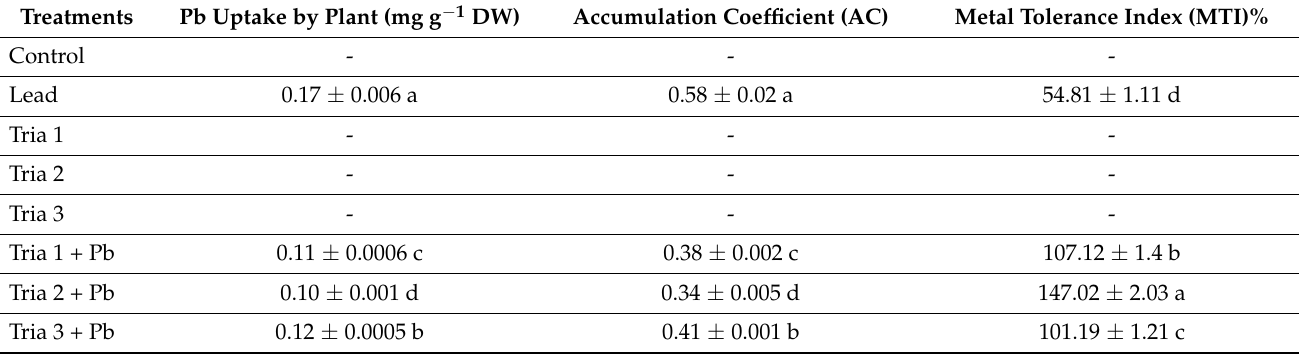
Table 4. Impact of Pb and Triacontanol on the Uptake, Accumulation, and Tolerance Index of Pb on Phaseolus vulgaris L.